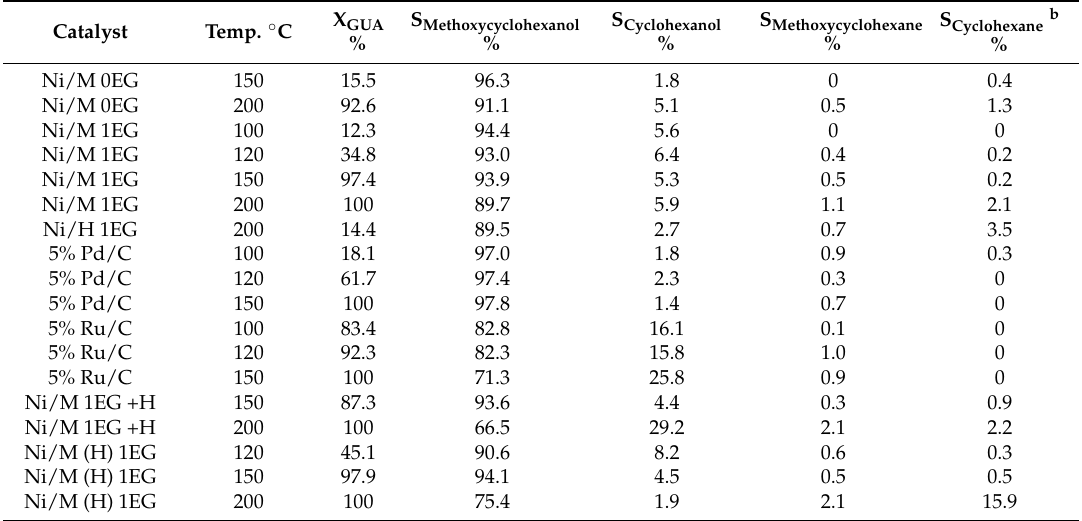
a Reaction conditions: 1.0 g guaiacol, 9.0 g n ‐ dodecane (solvent), 0.15 g Ni ‐ based catalysts, 0.15 g commercial